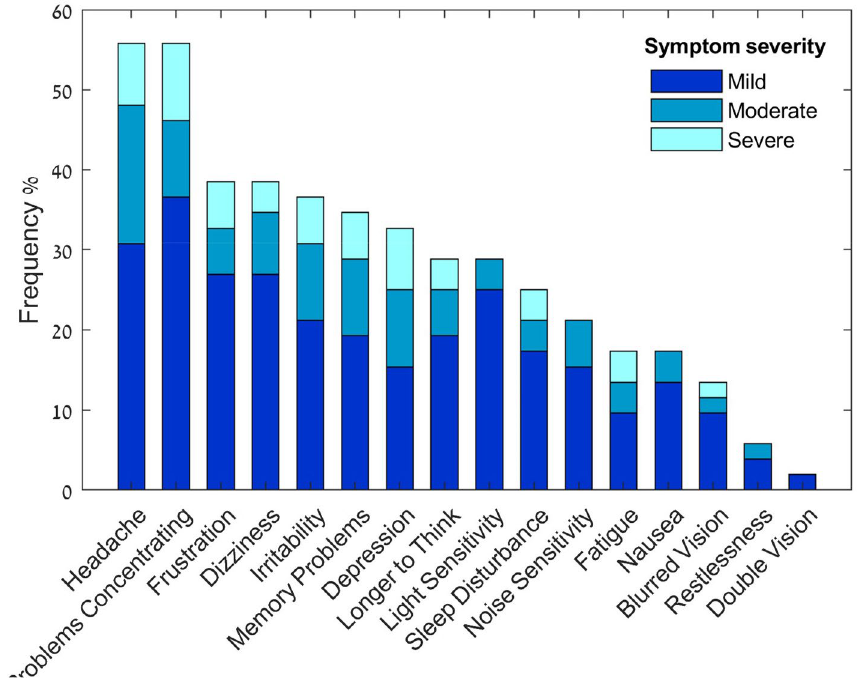
Figure 4. Frequency and severity of symptoms for children with persistent post-concussion syndrome after mild traumatic brain injury (n = 52).